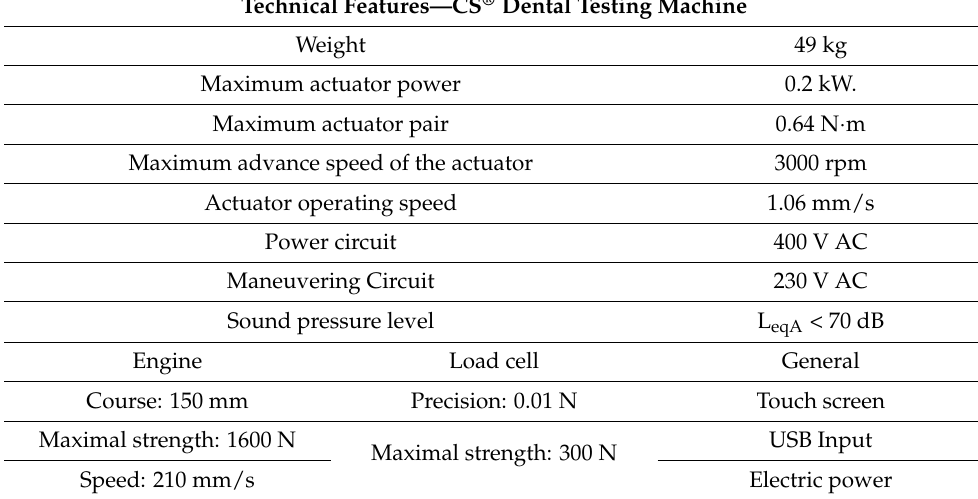
Table 1. Technical Features—CS®Dental Testing Machine.